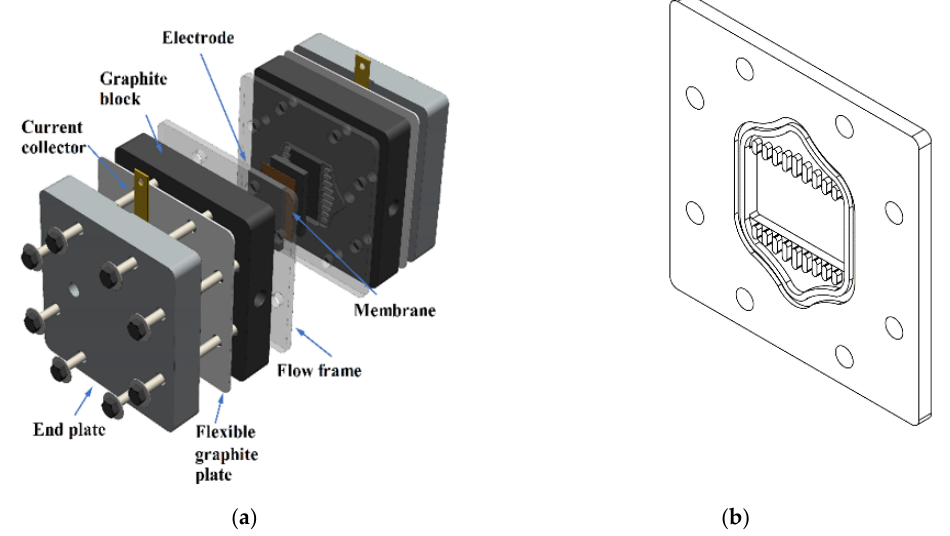
Figure 1. ( a ) Diagram showing different components of a VRFB assembly; ( b ) flow pattern on the PVC frame.